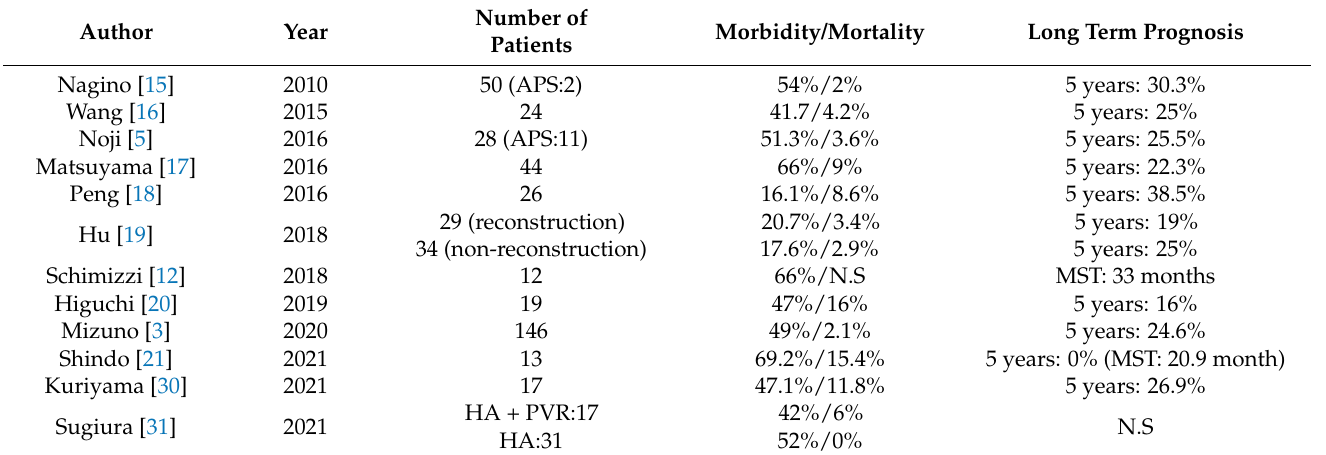
Table 2. Cases of concomitant hepatic artery resection for perihilar cholangiocarcinoma reported after